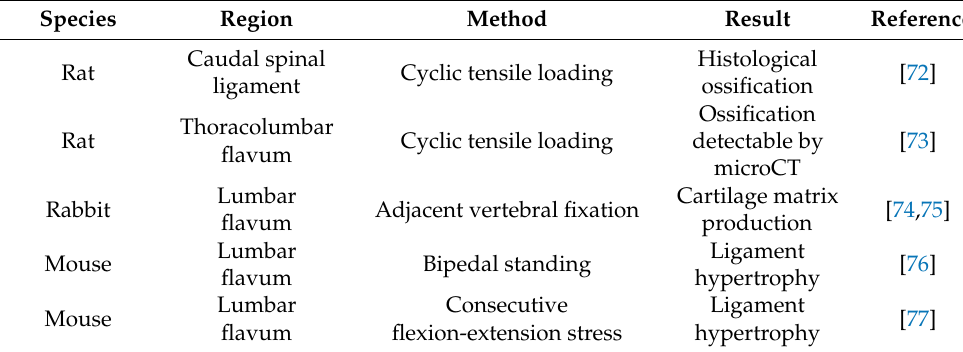
Table 1. Mechanical stress models of the spinal